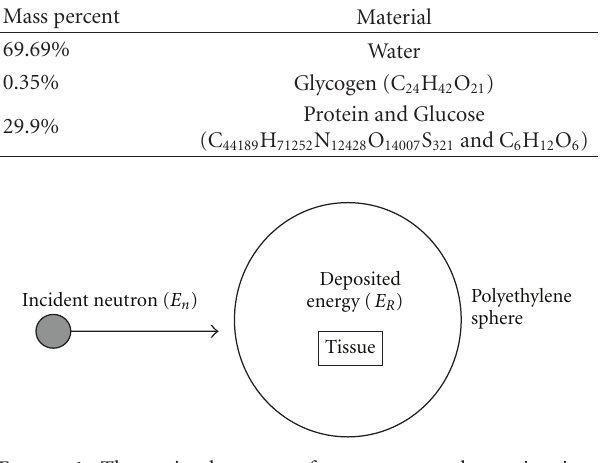
Figure 1: The emitted neutron from source and entering into sphere including